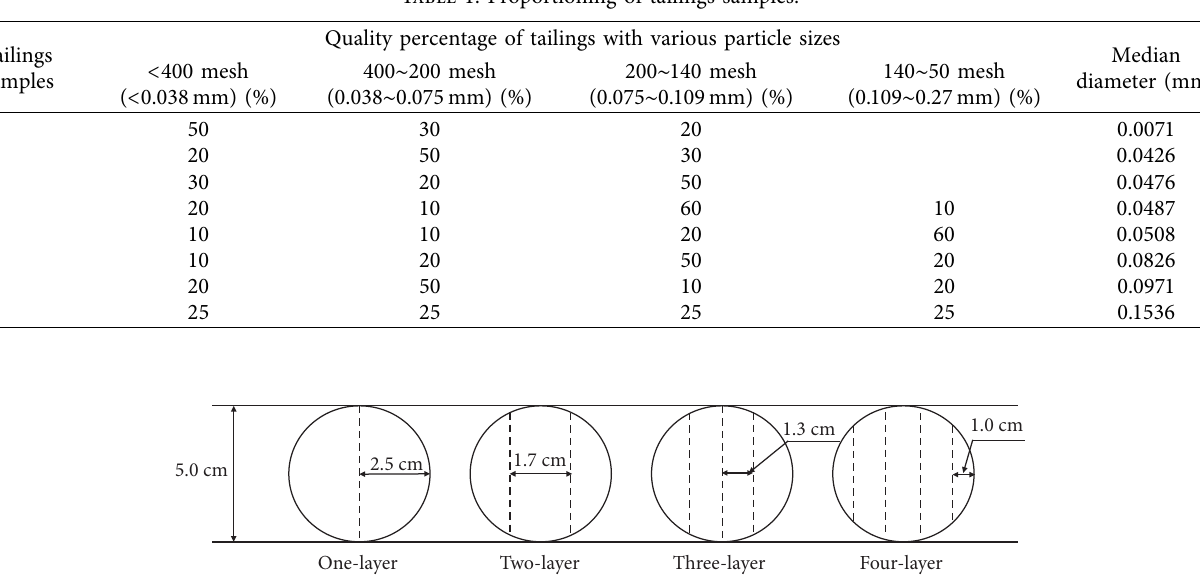
Figure 3: Diagrams of different geogrid arrangements and reinforcement space.